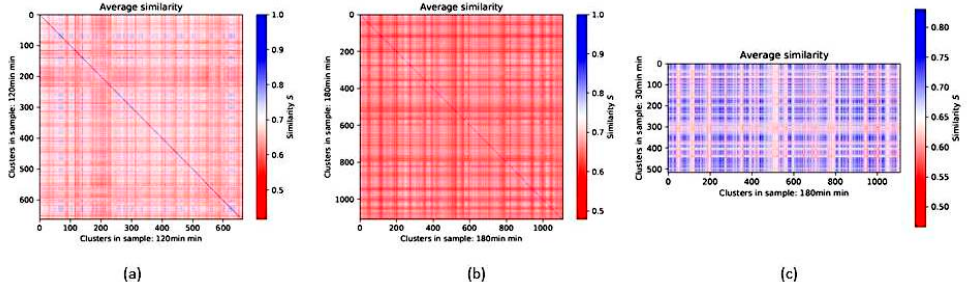
Figure 18. Averaged similarity heatmaps of γ H2AX clusters of a fibroblast cell line. The values show a similarity measure based on the Jaccard index used to evaluate persistence homology data. The values vary between 0 (no topological similarity) and 1 (topological identity). Pairwise comparison of clusters ( a ) 120 min, ( b ) 180 min after irradiation. ( c ) Comparison of 30 min with 180 min clusters. Note: the differences in the color bars of the heatmaps comparing the same time point and comparing different time points. (Parts of this figure and a modified figure legend was originally published under CC ‐ BY license in [133].).